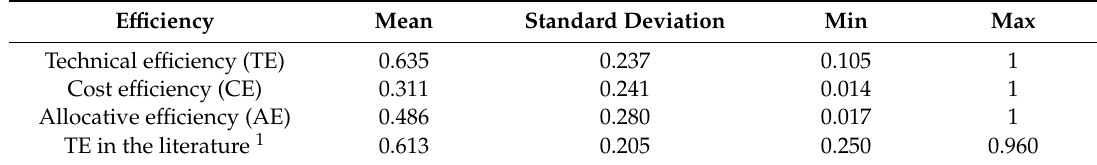
Table 2. Average e ffi ciency scores of Red River Delta fish farms in 2018.